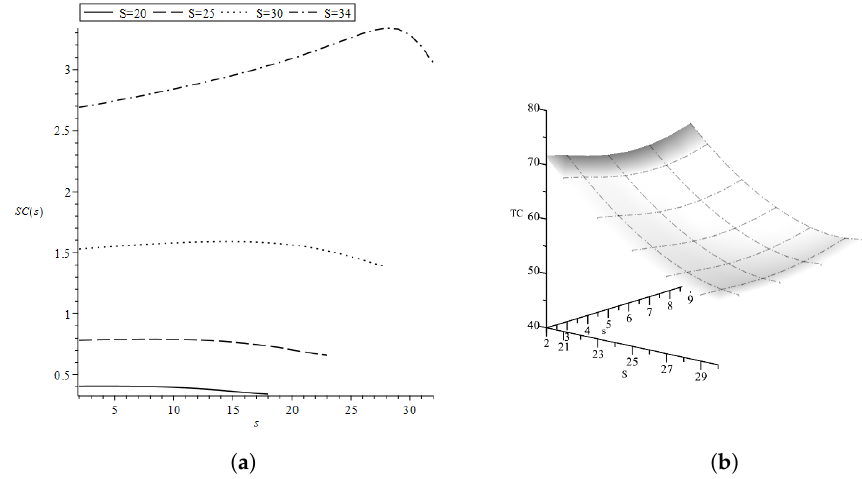
Figure 4. ( a ) SC ( s ) for S ∈ { 20,25,30,34 } , M = 35. ( b ) TC ( M = 35, S , s ) as a function of S and s